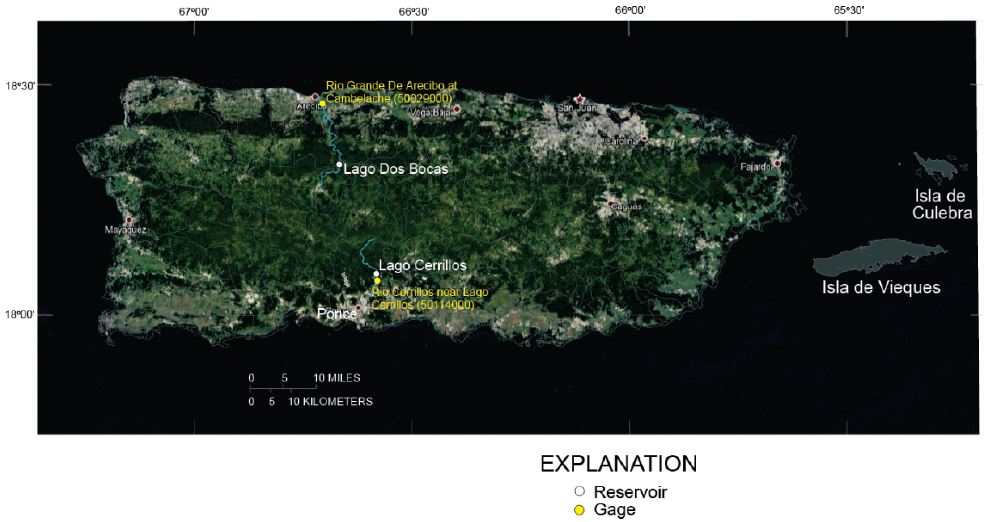
Figure 4. Reservoirs with substantial effects on river flows.